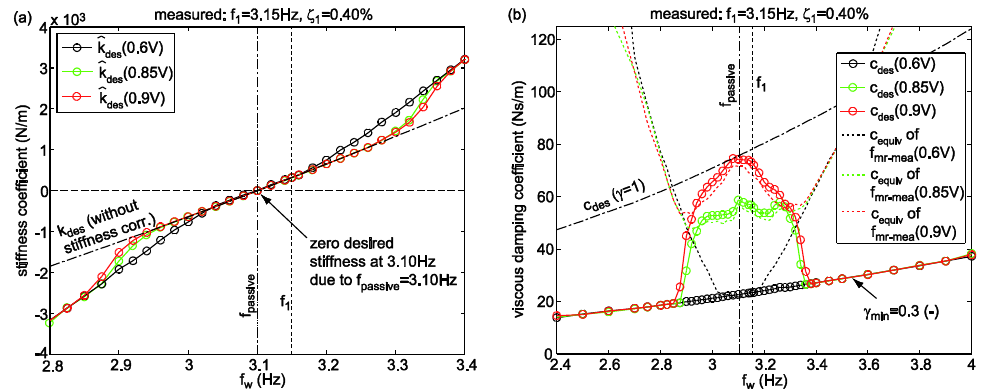
Figure 13. Measured ( a ) desired corrected stiffness and ( b ) desired viscous damping coefficient (including damping gain γ ) accompanied by equivalent (actual) viscous damping